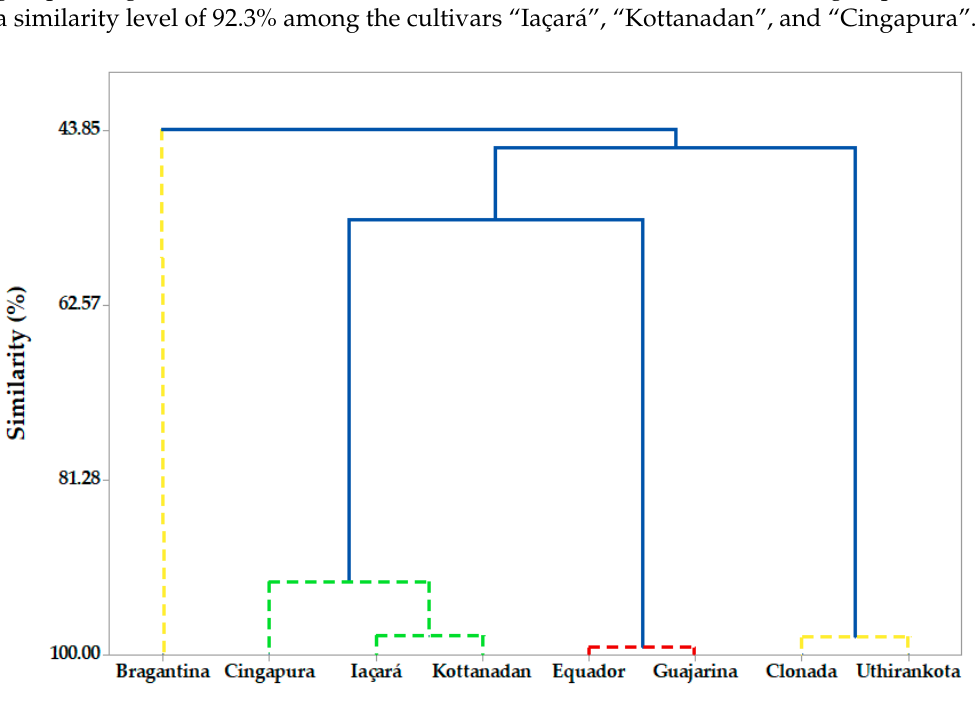
Figure 3. Hierarchical cluster analysis (HCA) analysis from volatile concentrates of black pepper. Different colors in the groups indicate the potential degrees of susceptibility of the cultivars to Fusarium oxysporum (yellow wilt disease). Susceptible; Medium tolerance; Tolerant.